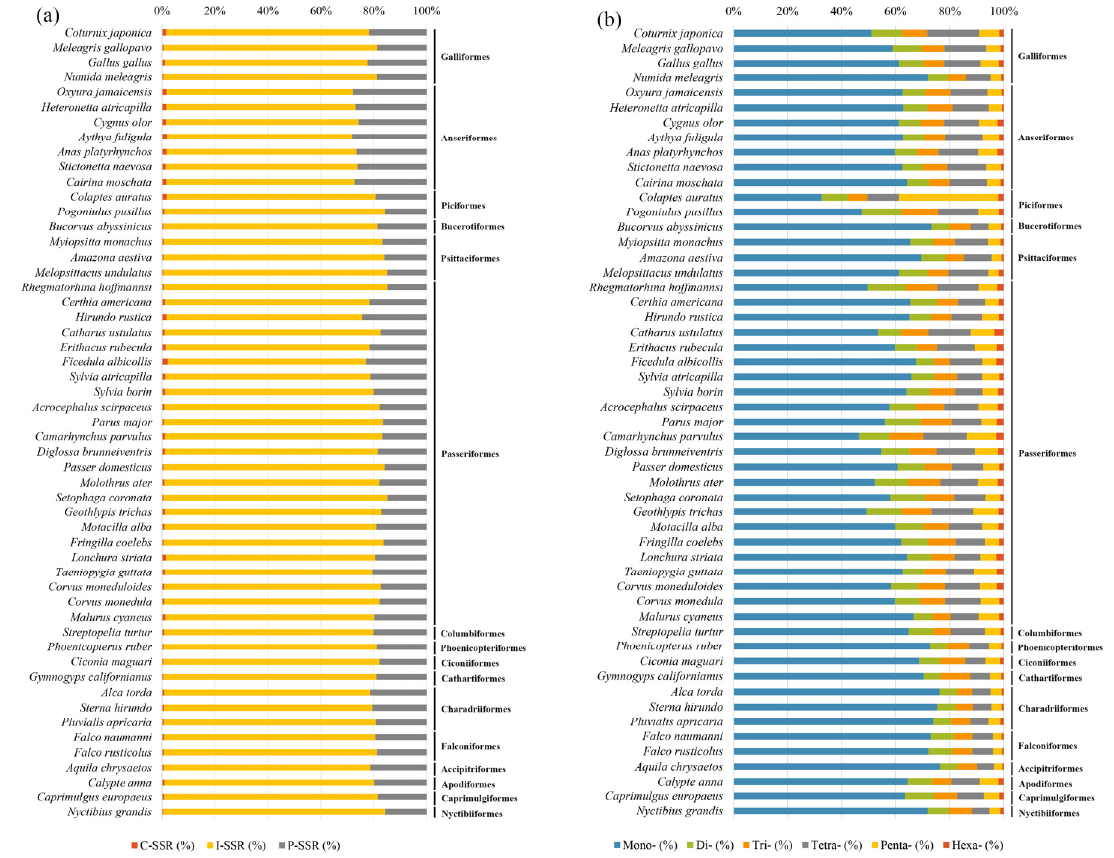
Figure 1. Proportion of each type of SSRs ( a ) and P-SSRs ( b ).